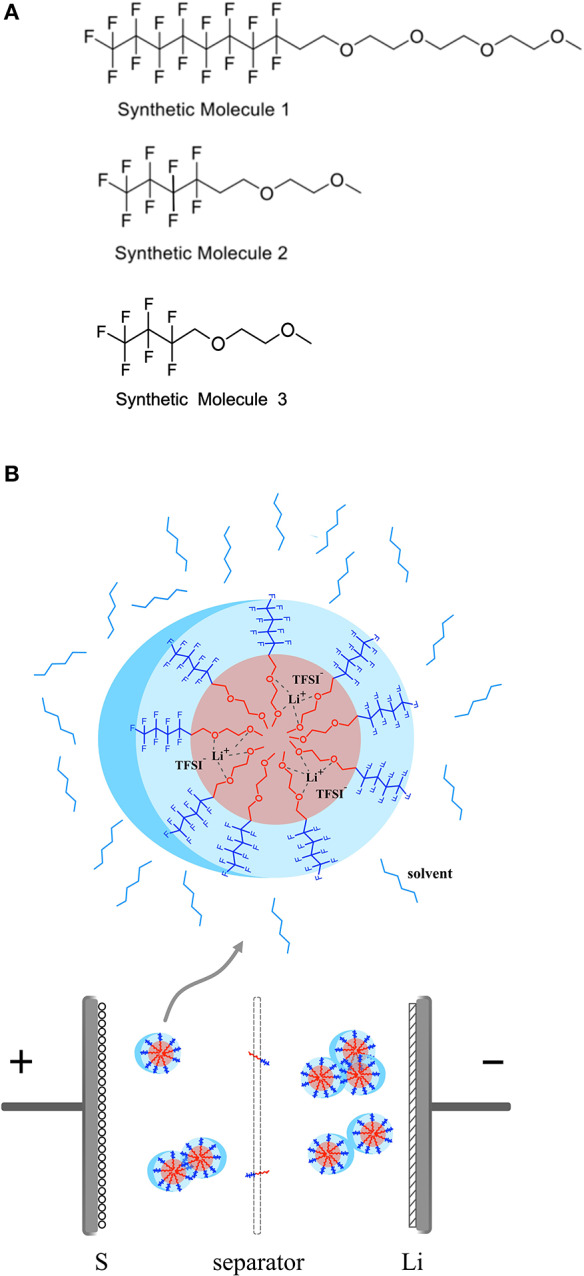
(A) Molecular structure of fluorocarbon ethylene oxides with different chain length denotated as F8EO4, F4EO2, and F3EO1 respectively. (B) Schematic diagram to show solvation mechanism of LiTFSI with HFE in the electrolyte and formation of micelle complex structure.